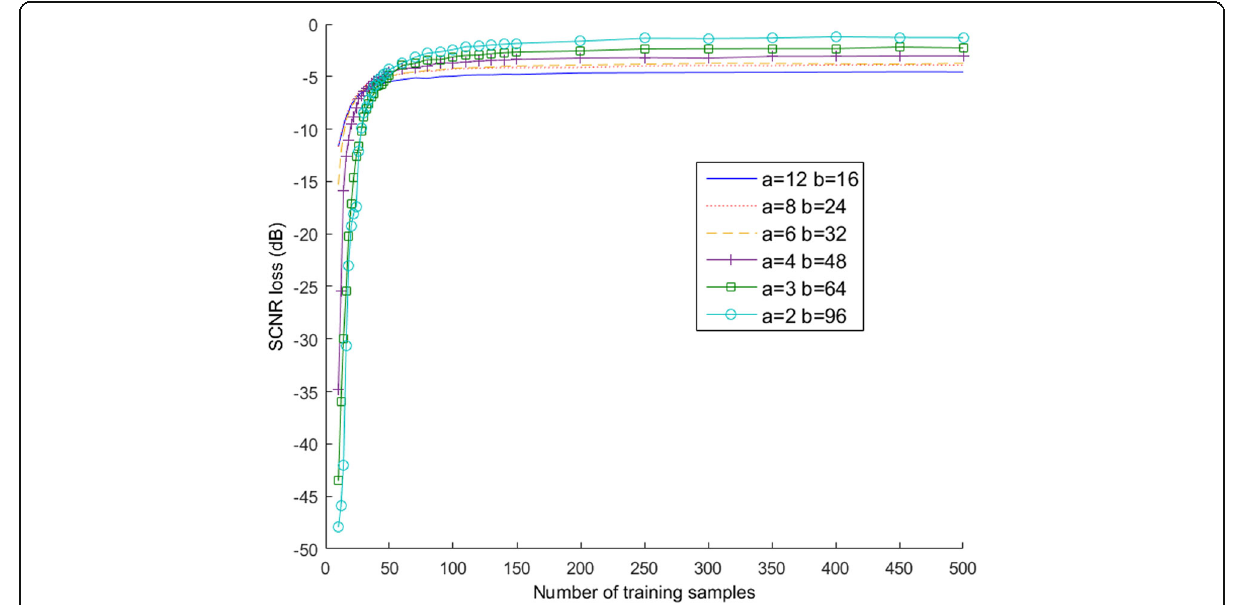
Fig. 3 Training sample convergence rates for different a and